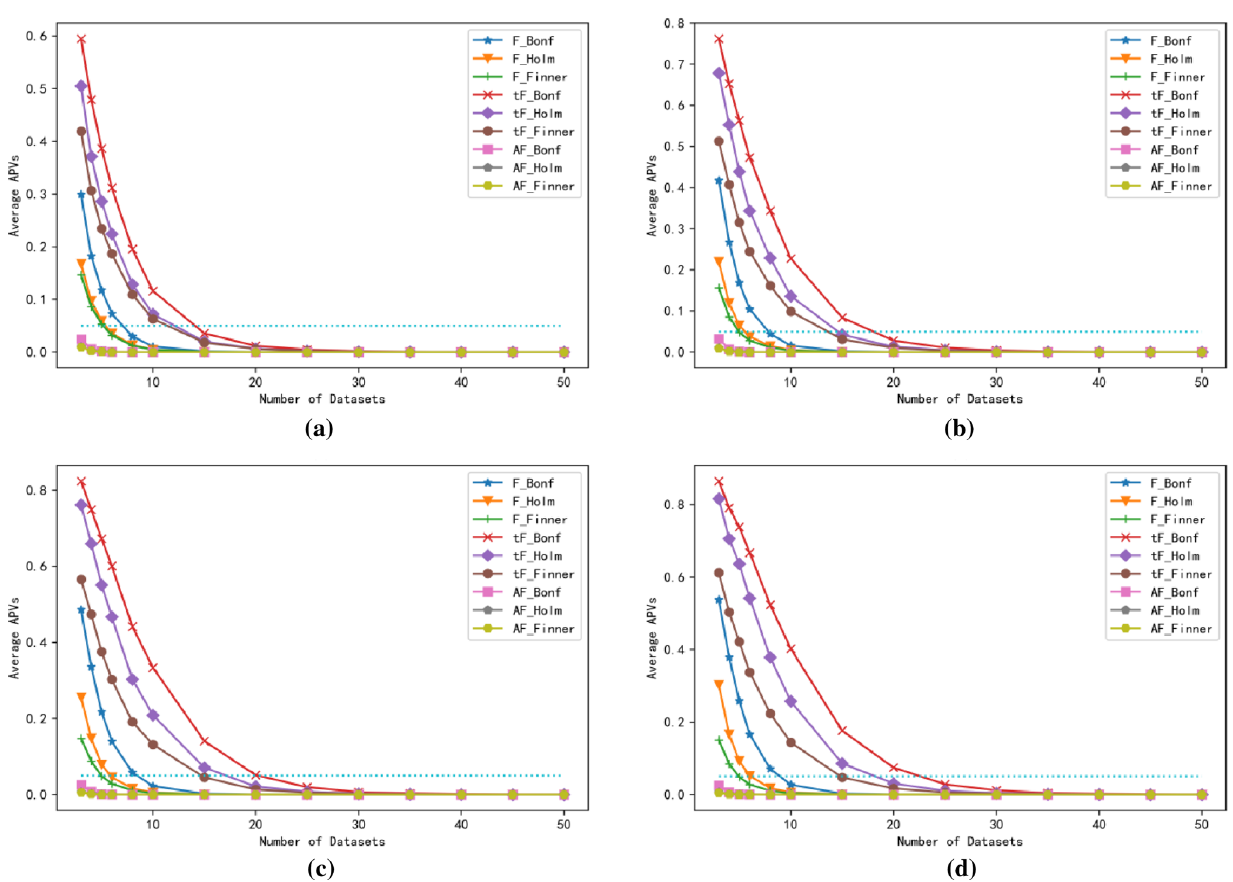
Fig. 10 Average APVs of different nonparametric statistical tests under the experiment setting vi: a the number of algorithms K = 4; b K = 6; c K = 8; d K =